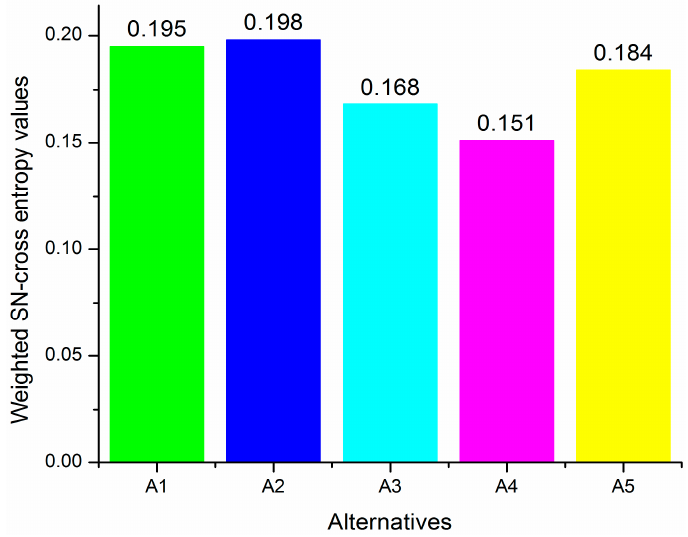
Figure 2. Bar diagram of alternatives versus weighted NS-cross entropy values of alternatives.